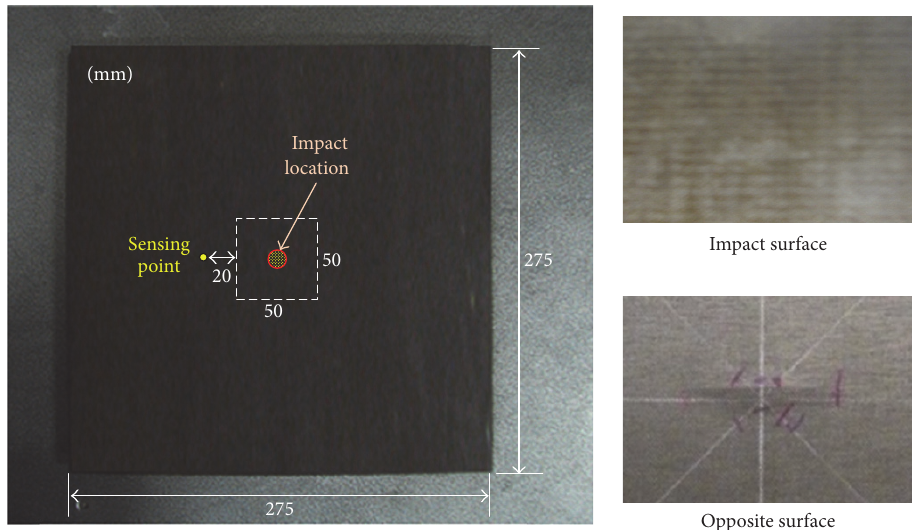
Figure 4: Target composite plate with the impact-induced delamination and the laser scanning